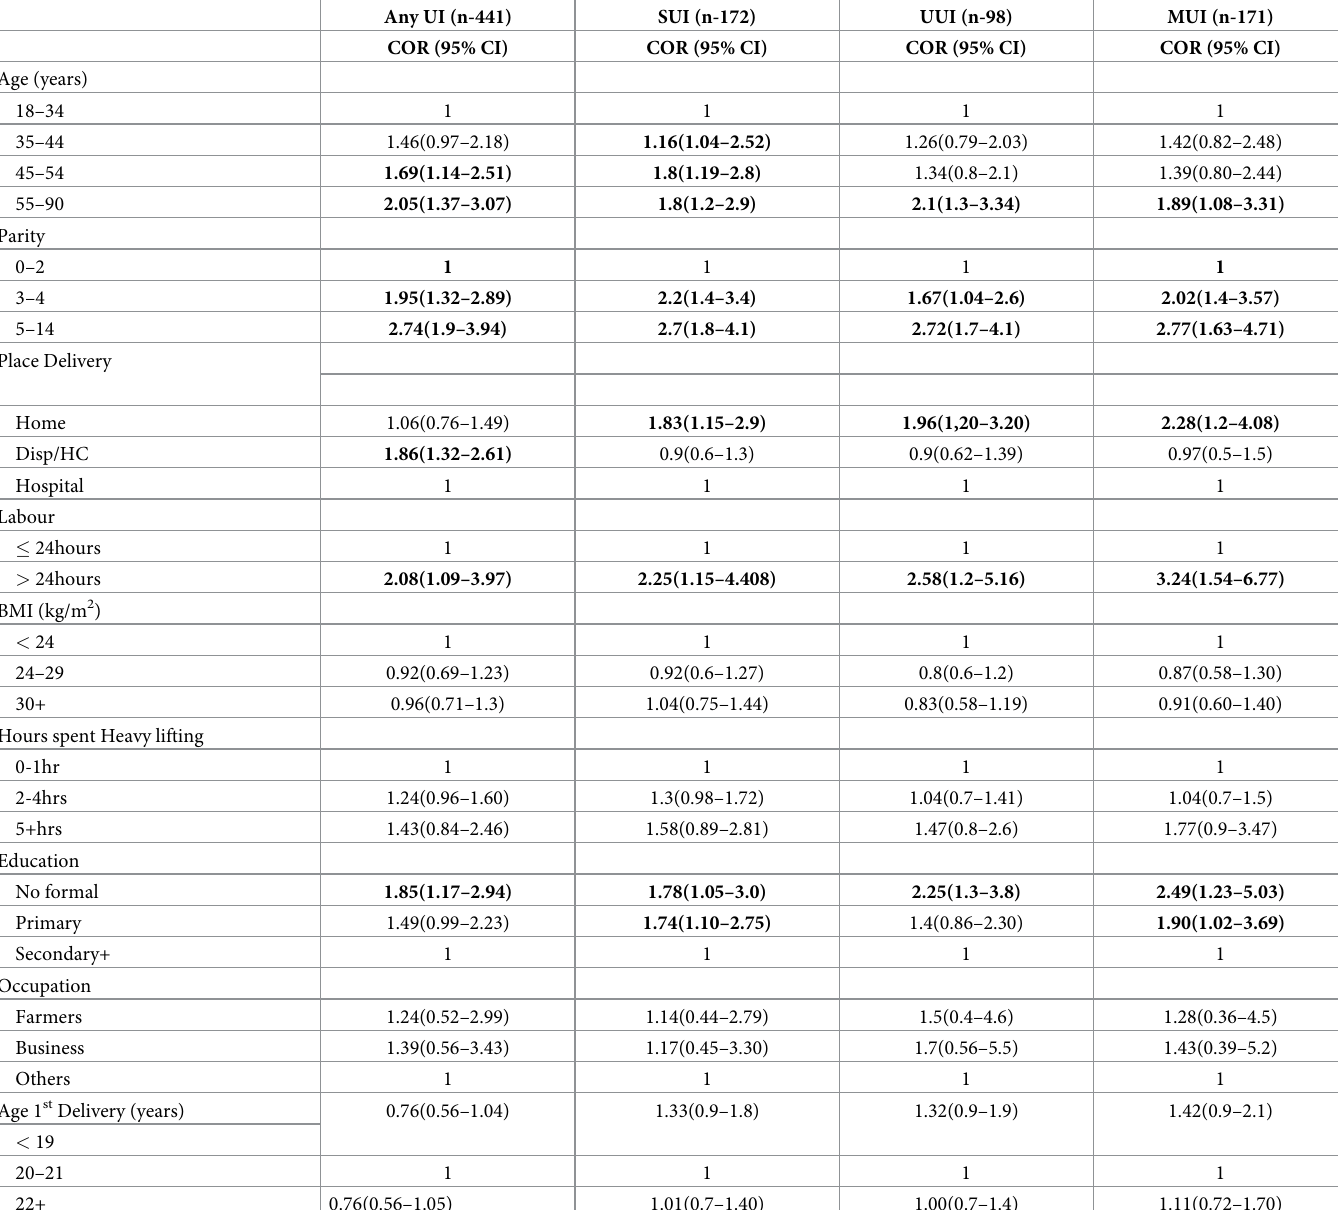
Table 2. Univariate analysis showing risk factors associated with any UI, SUI, UUI, and